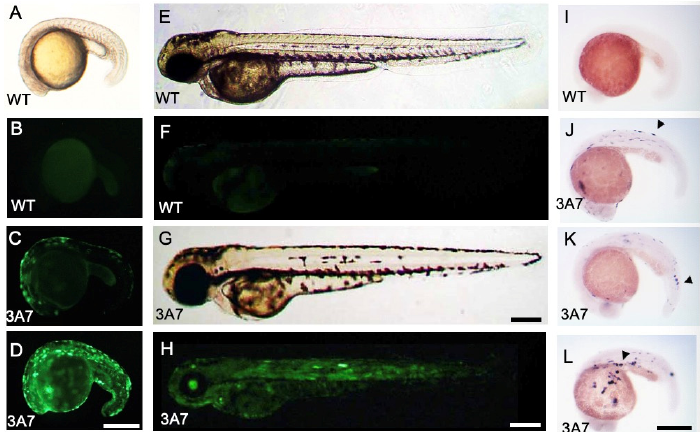
Figure 1. EGFP and CYP3A7 expression in hCYP3A7/EGFP-expressing zebrafish. A pT2A plasmid containing hCYP3A7/EGFP (3A7: C , D , G , H , J – L ) was injected together with transposase cmRNA into 1-cell stage embryos. ( A – D ): 17 hpf, ( E – H ): 50 hpf. EGFP fluorescence in wild-type (WT) zebrafish ( B , F ) and that in hCYP3A7-expressing zebrafish (hCYP3A7 zebrafish, 3A7) ( C , D , H ) are shown. Image ( A ) is a bright field image of a wild-type embryo. Images ( E , G ) are bright field images of ( F , H ), respectively. CYP3A7 mRNA expression was observed at 23 hpf by WISH ( I – L ). Arrowheads indicate examples of positive signals in J – L . Scale bars = 200 µm.